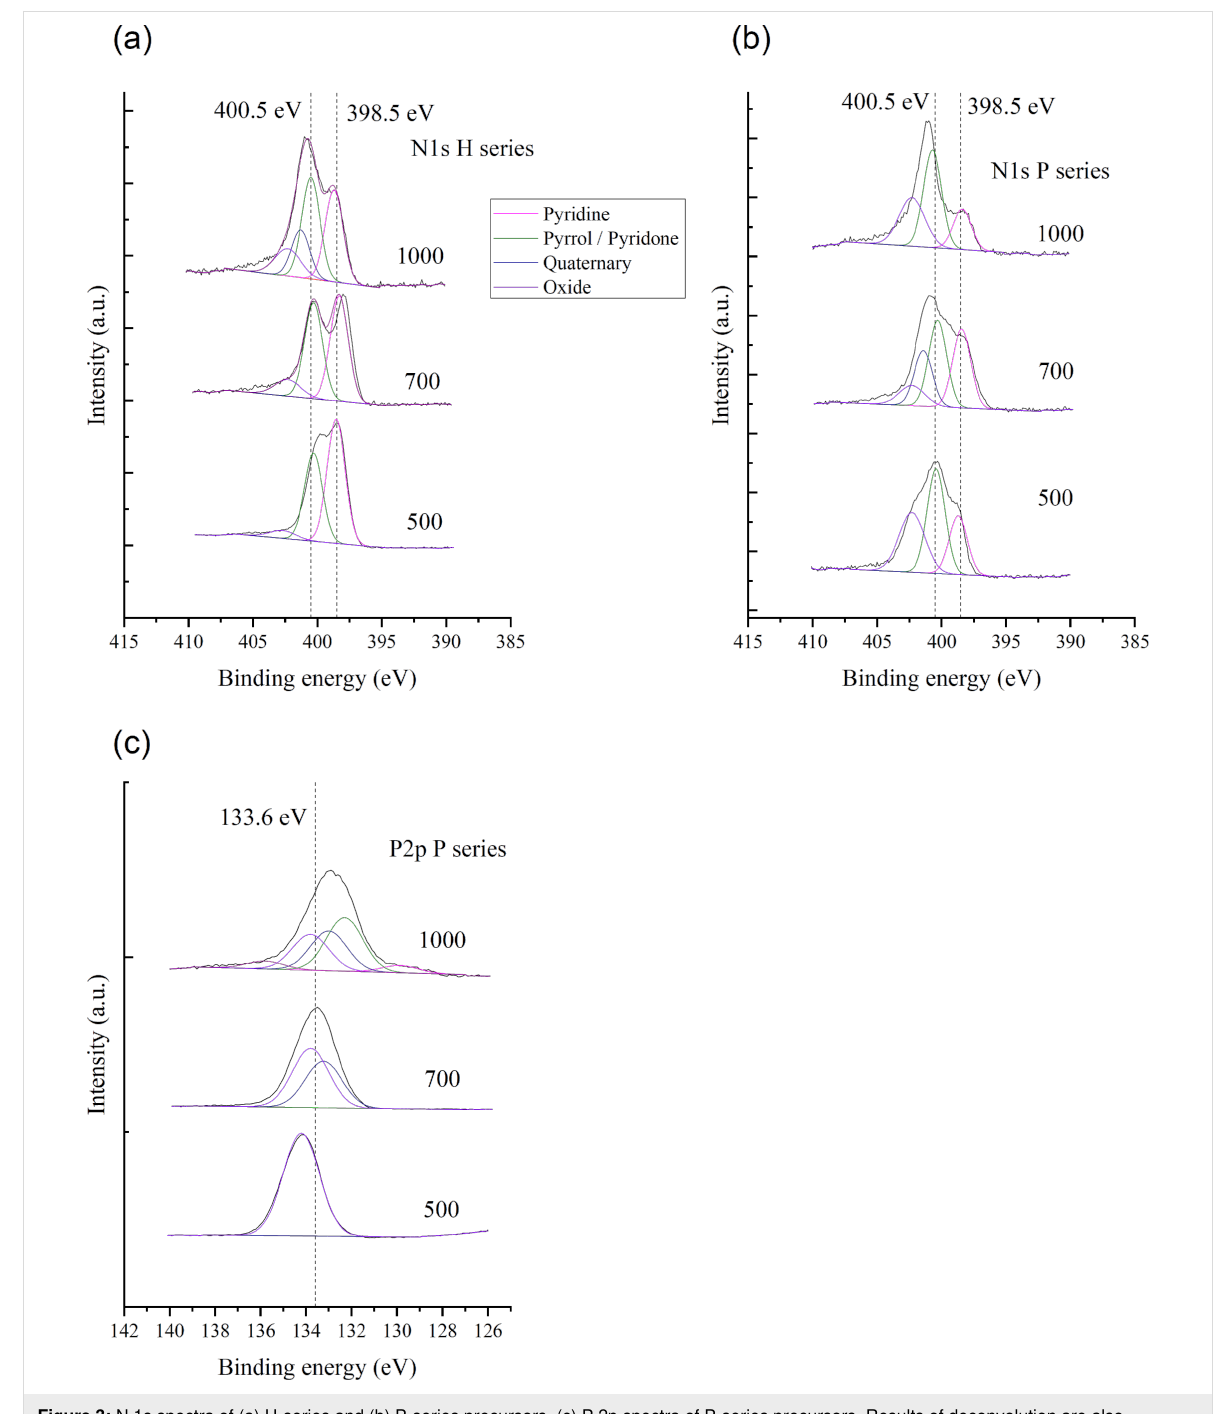
Figure 3: N 1s spectra of (a) H-series and (b) P-series precursors. (c) P 2p spectra of P-series precursors. Results of deconvolution are also presented.